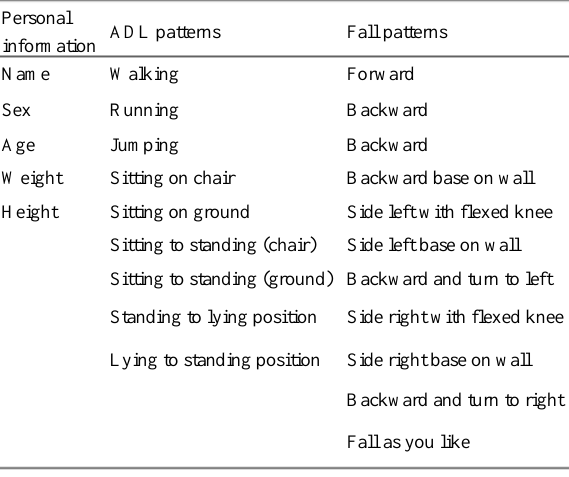
Table 1. Experiment log including personal information, ADL and fall